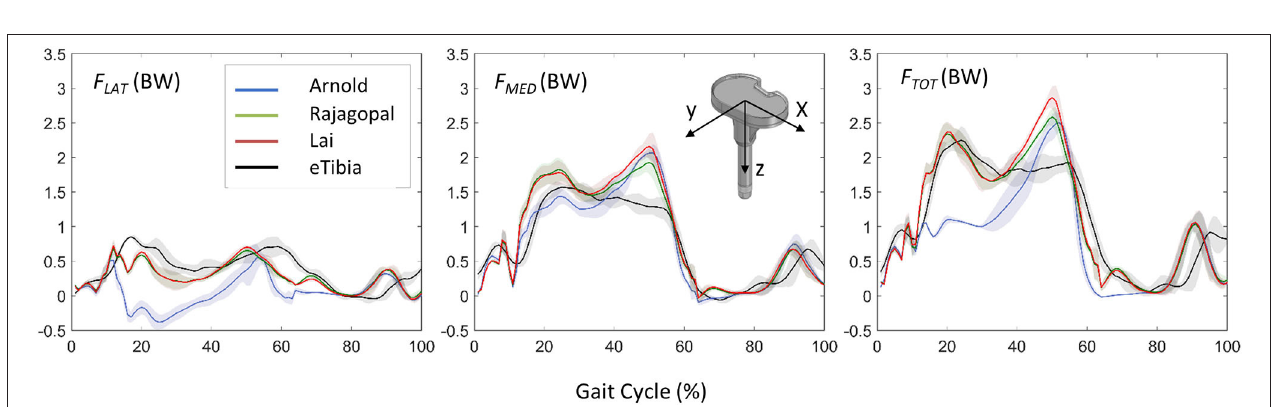
FIGURE 6 | Comparison between the predicted loads and the in vivo measurements in terms of lateral, medial, and total forces acting on the TI component and expressed in the coordinate reference systems of the instrumented eTibia device.